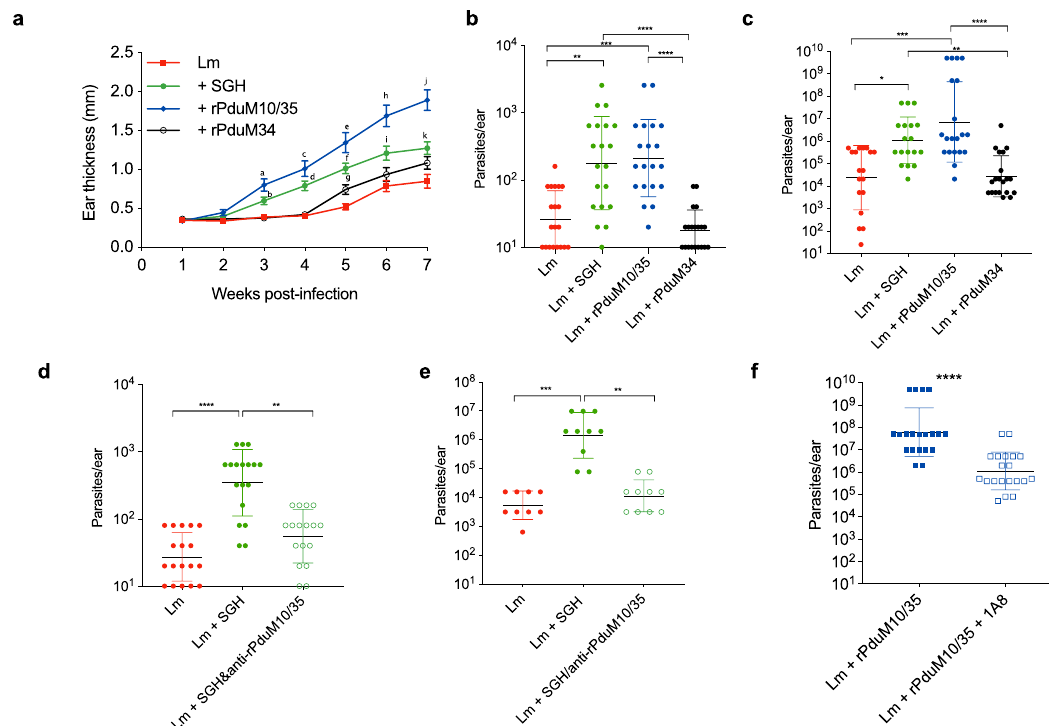
Fig. 4 Sand fl y salivary yellow proteins exacerbate Leishmania infection. a – c C57BL6 mice ears were infected with L. major metacyclics (500 parasites) in PBS or with rPduM10 + rPduM35 (0.125 μ M of each), P. duboscqi SGH (0.5 pair) or rPduM34 (0.25 μ M). a Ear thickness was measured every week. Parasite load assessed by limiting dilution assay at b 1 or c 7 weeks post infection. d , e C57BL/6 mouse ears were infected with L. major metacyclics (500 parasites) in PBS or with 0.5 pair equivalent of P. duboscqi SGH premixed or not with antibodies against PduM10 or PduM35 (1:100 dilution). Parasite load assessed by limiting dilution assay at 1 ( d ) or 6 weeks ( e ) post infection. f Anti-Ly6G (clone 1A8) antibody was administered intraperitoneally to C57BL/6 mice 18 h before infection. C57BL6 mouse ears were infected with L. major metacyclics (500 parasites) in PBS or with rPduM10 +